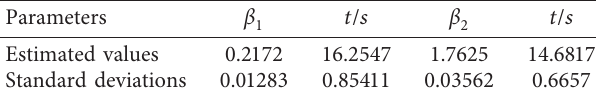
Table 2: Estimated value and standard deviation of β